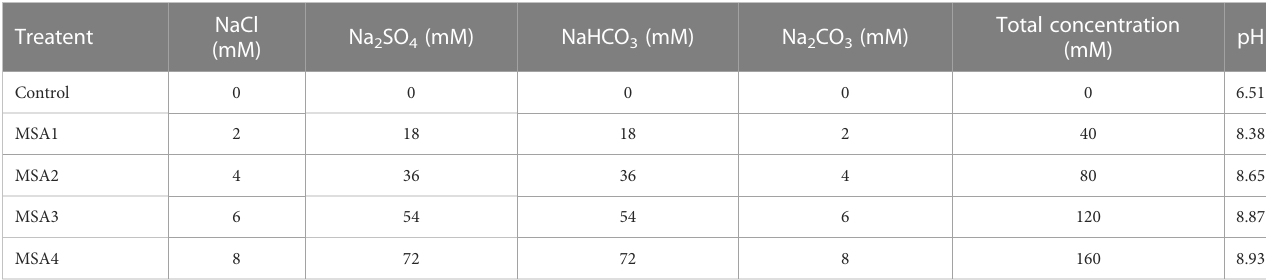
TABLE 1 Salt composition and pH of each